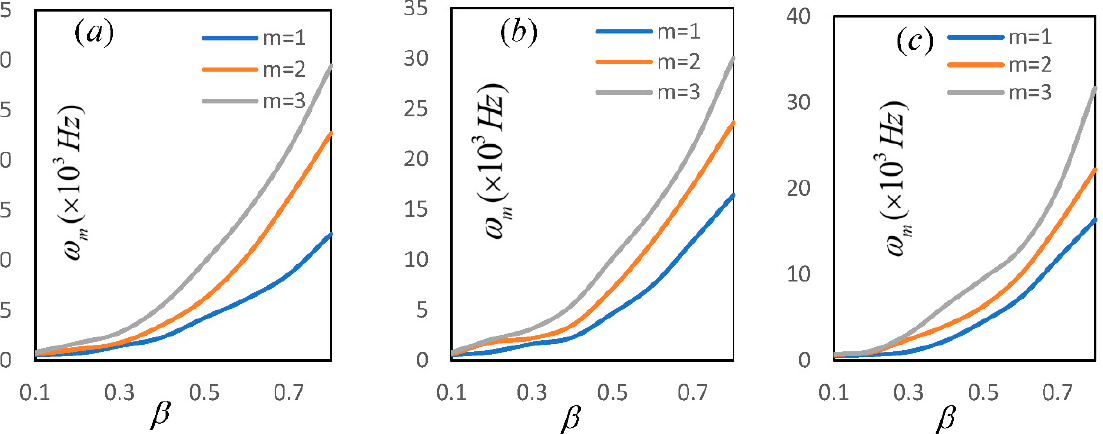
Figure 4. The relation of angular frequency parameter and radii ratio β of two-layered annular circular plates with ply orientation 45 0 / − 45 0 : ( a ) EGE / EGE ( b ) AGE / AGE . η = 1.5, n = 2 and γ = 0.05.